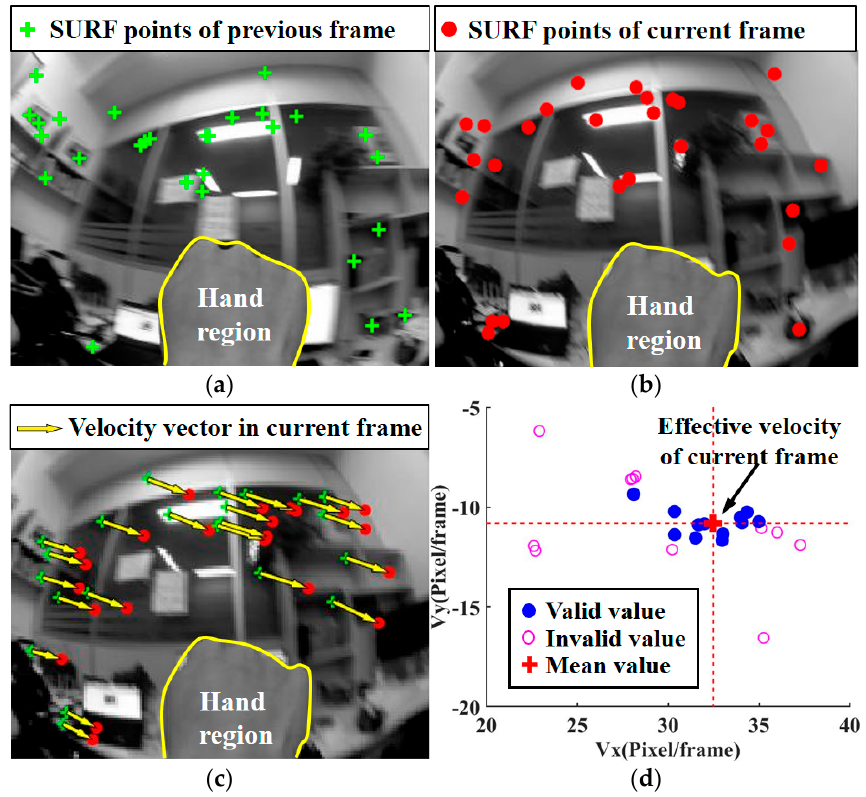
Figure 6. Speeded-Up Robust Features (SURF) keypoints are extracted, and the average displacement of matching keypoints between the adjacent frames was used to characterize the velocity of background. ( a ) The extracted SURF keypoints of the previous image frame; ( b ) The extracted SURF keypoints of the current image frame; ( c ) The matching keypoints between adjacent image frames; ( d ) Determination of the effective values of current frame’s velocity.